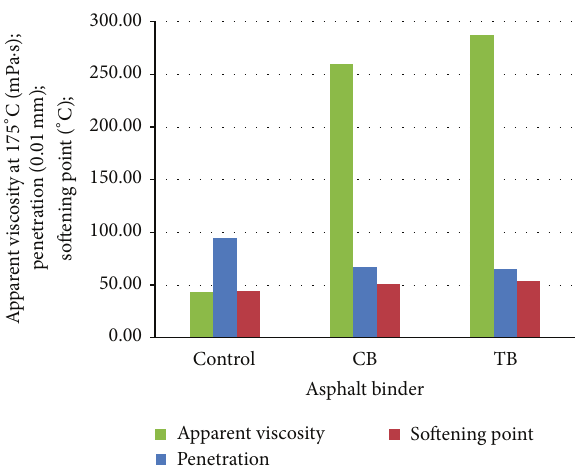
Figure 3: Characterization tests of the